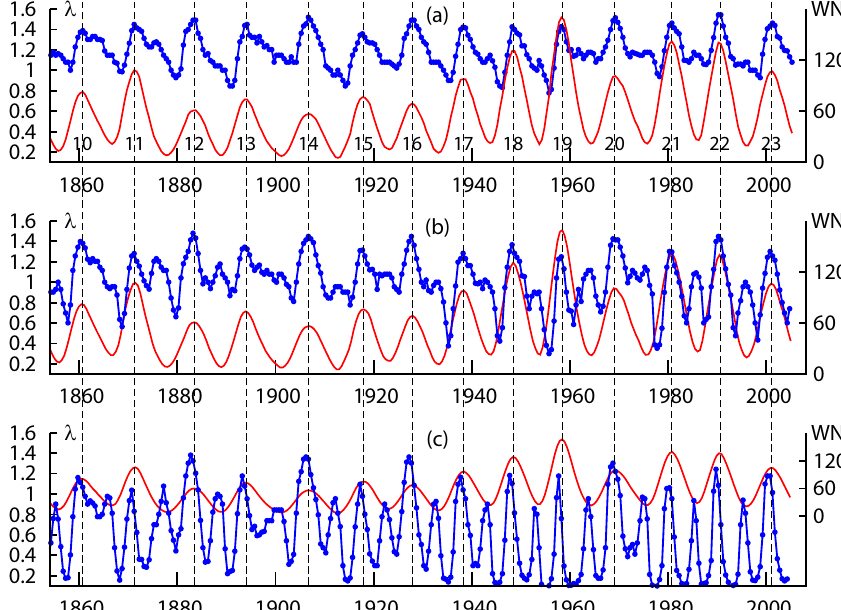
Figure 1. The irregularity index λ (blue) computed in a 4-year sliding window for the ISSN averaged over 162 (top panel), 324 (middle panel), and 648 (bottom panel) days; embedding dimension m =1. The Wolf numbers averaged first over N =162, 324, and 648 days, and then over 4 years are shown in red, together with solar cycle number. Dashed black vertical lines are located at the maxima of